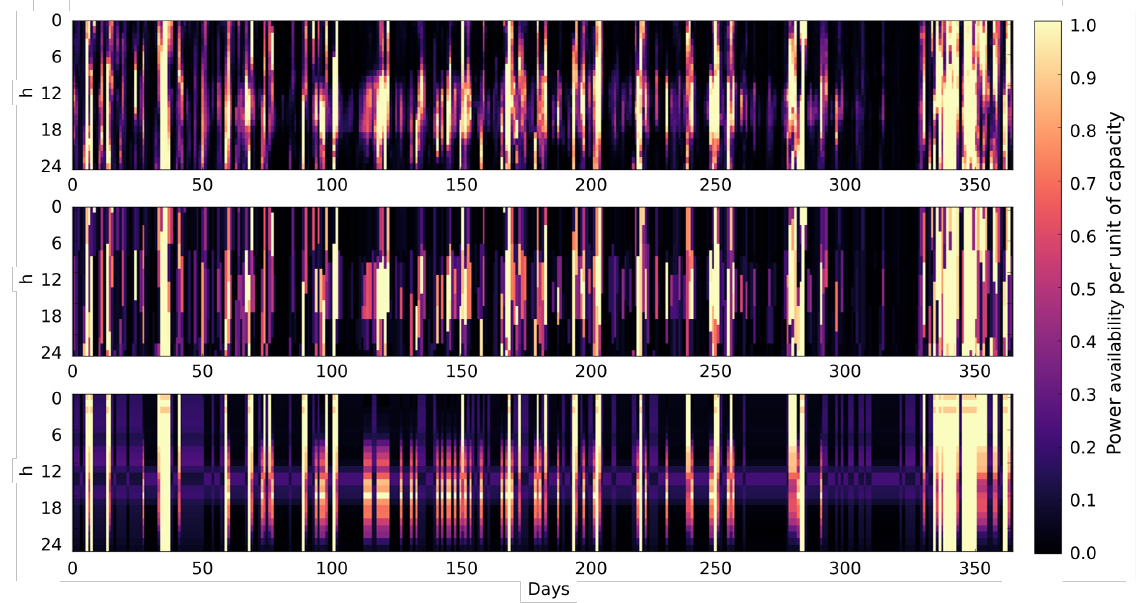
Figure 2. Time series for a wind generator with corresponding power availability. The graphics have a row for each hour of a day and a column for each day of the year. On top the reference series, in the middle the chronological clustering using 120 representative hours and at the bottom the coupling clustering using 5 representative